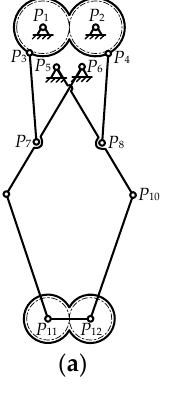
Figure 8. Hopping mechanism. ( a ) Optimization result. ( b ) Solid model.